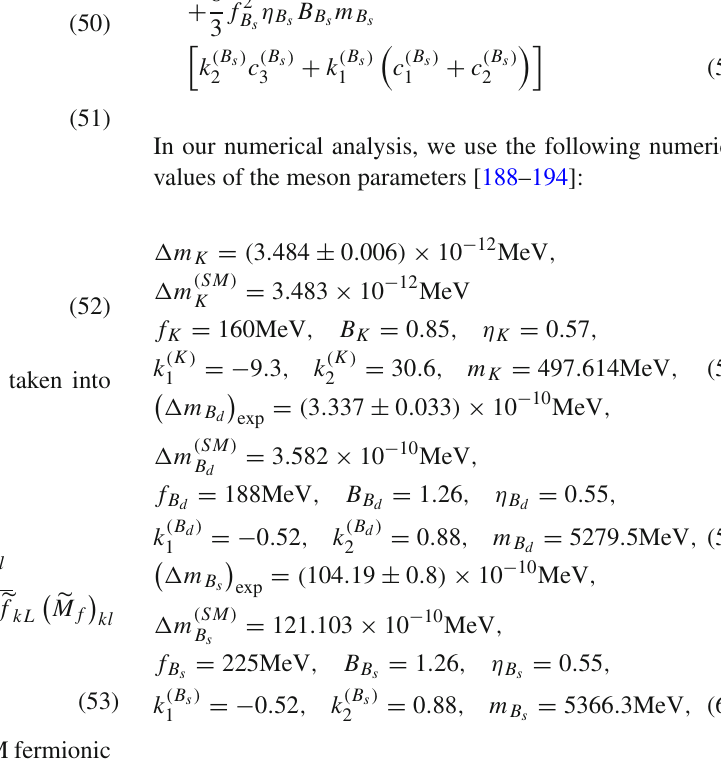
− ¯ B 0 (left-plot) d d